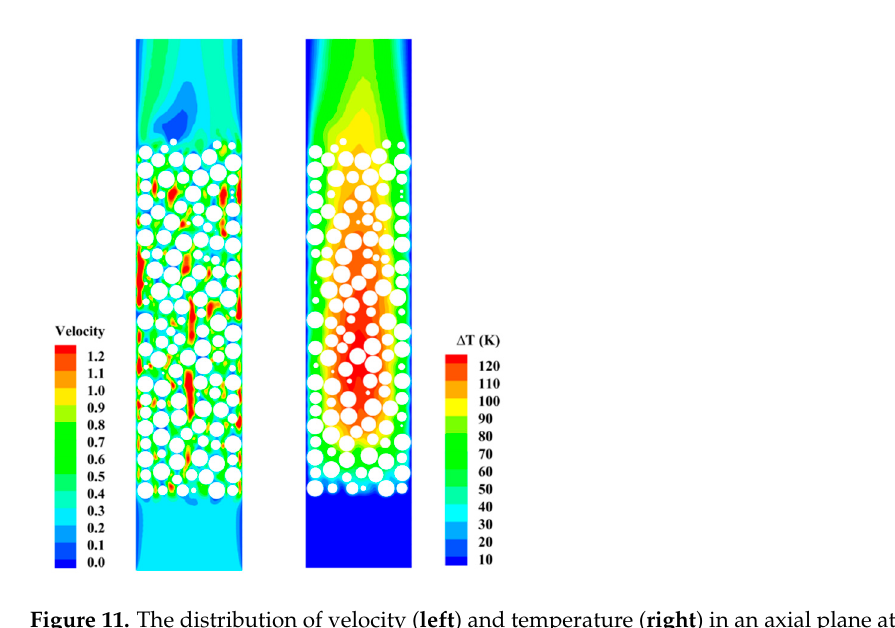
Figure 10. Grid independence test at various base sizes with a single OC particle: The profile of ( a ) conversion distribution and ( b ) reaction ∆ T distribution on the reference line at t = 50 s.